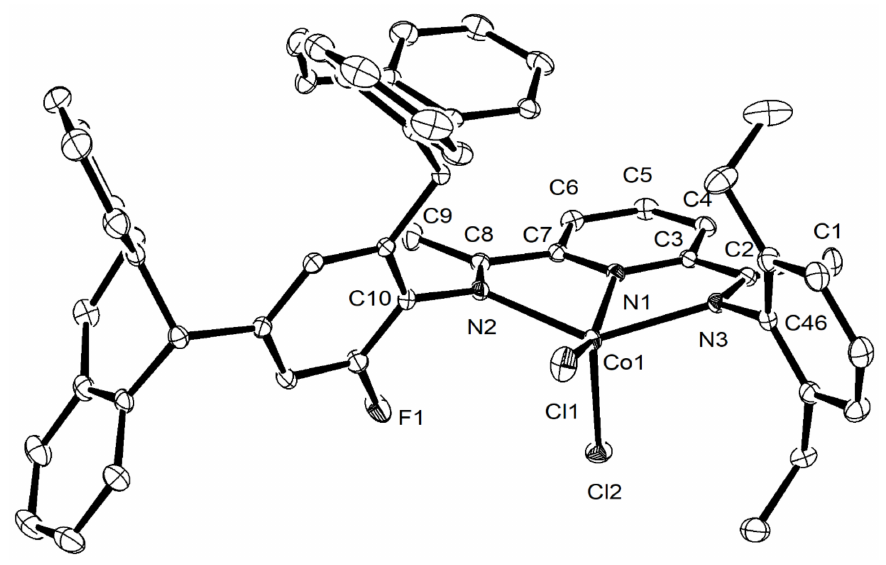
Figure 3. ORTEP representation of Co2 with the thermal ellipsoids set at the 30% probability level. All hydrogen atoms have been omitted for